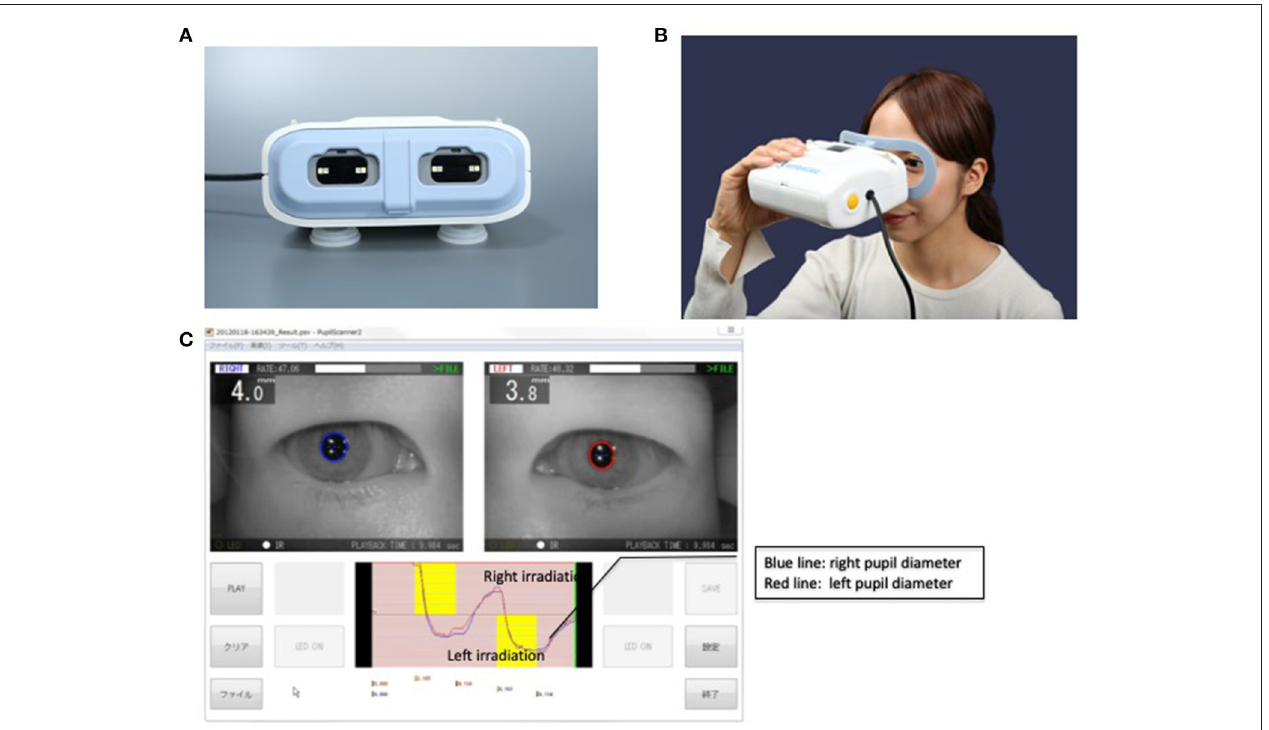
FIGURE 1 | The Hitomiru ® pupillometer. (A) The shape of the Hitomiru ® device is like a glass with light sources and a video camera which allows automatically captures the image of pupils. The captured data is sent to the computer, which is connected to the pupillometer, then the diameters are recorded and analyzed with included proprietary software. (B) The Hitomiru ® pupillometer used on a volunteer. (C) Measurement screen of the device. In the upper image, the right and left pupil is captured with a blue and red circle, respectively. In the lower image, the blue and red line shows a right and left pupil diameter, respectively. The yellow zone in the upper and lower section of the graph shows the right and left eye irradiation, respectively. When the irradiation induces miosis, the lines go downward. Conversely, when the cessation of irradiation induces a mydriasis, the lines go